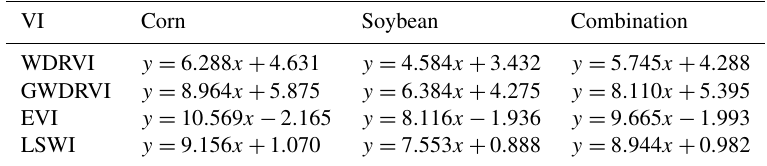
Table 1. Linear equations for LAI ( y ) as a function of VI ( x ) for corn, soybean, and the combination of corn and soybean.